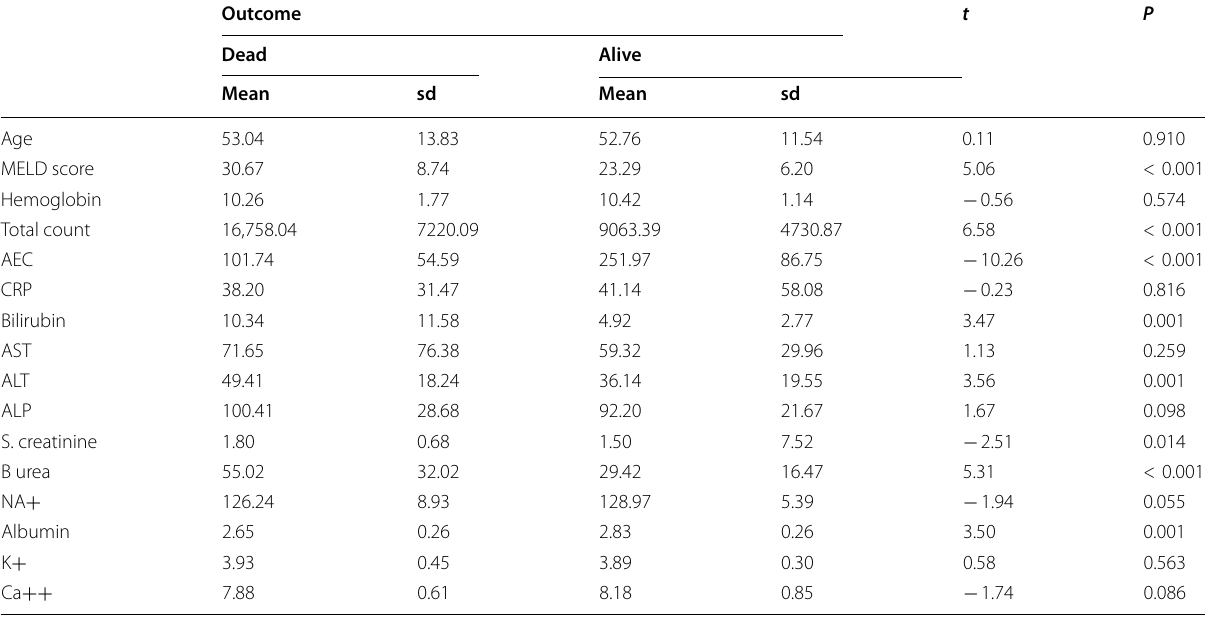
Table 4 Statistical analysis of various variables in predicting mortality